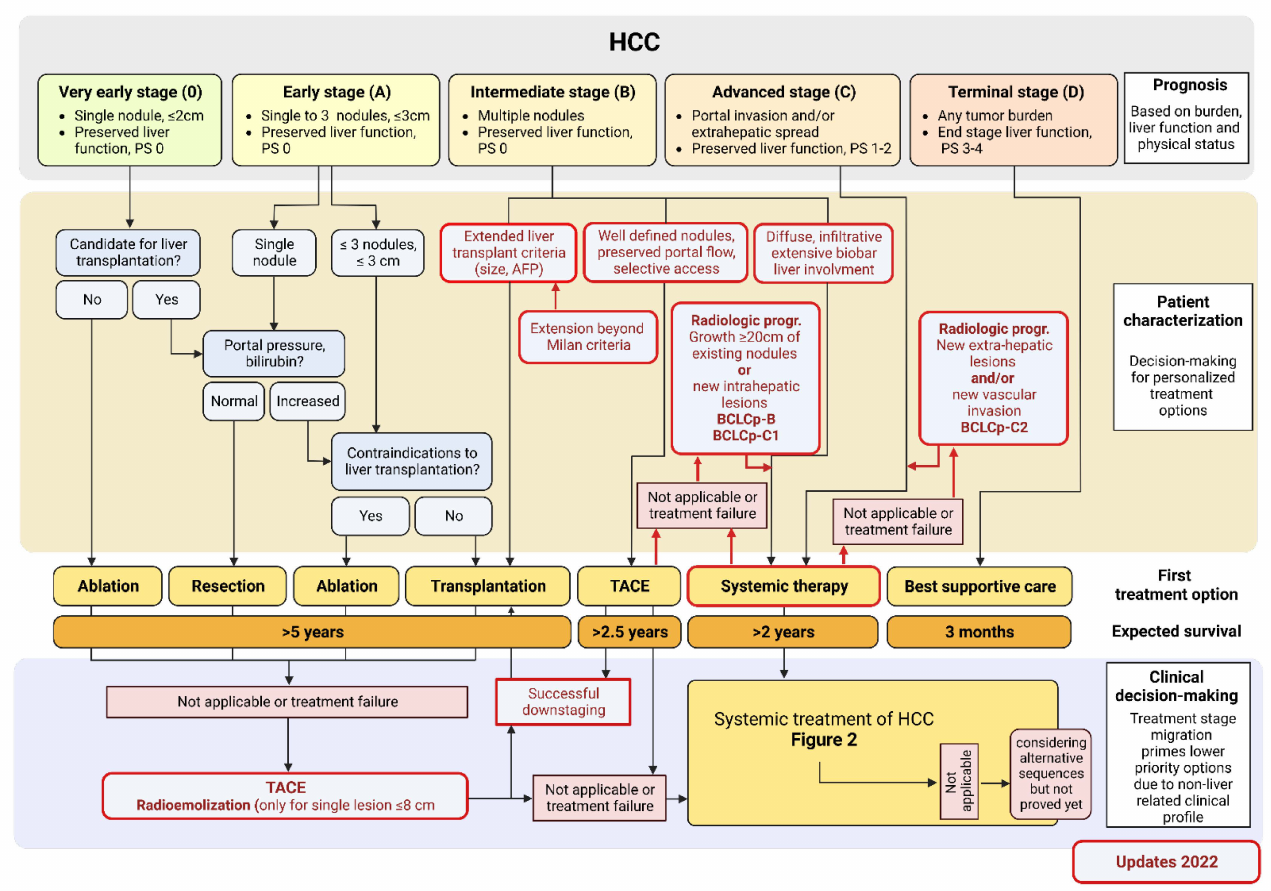
Figure 1. The BCLC classification system offers treatment recommendations based on tumor stage and liver function of patients with HCC. Treatment options are adjusted to the 5 stages of HCC (from very early to terminal stage). The prognosis is based on the tumor burden, liver function and physical performance status of the patient. Besides the recommended treatments, the BCLC system also includes prognosis and the expected survival time. Updated classifications and treatment options are illustrated as red boxes and arrows. This updated BCLC system further contains new workflows during radiological progression within between the stages (BCLCp-B, BCLCp-C1, BCLCp-C2)